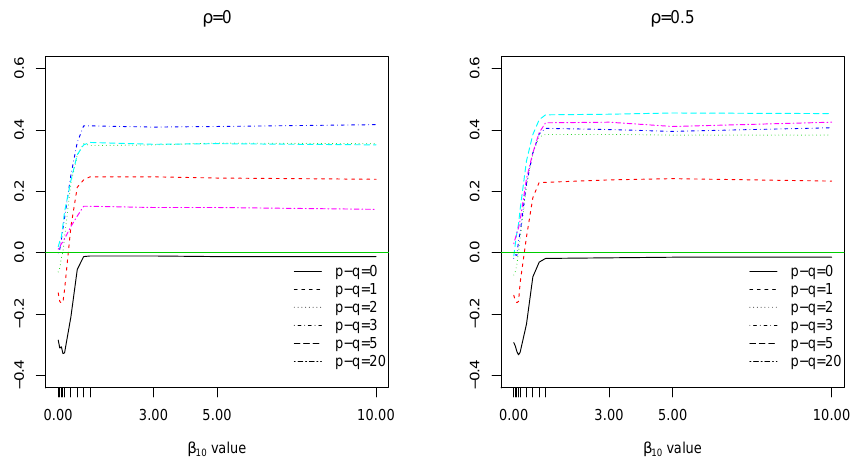
Figure 5. Difference in proportions of selecting true model: P c ( λ 1 se ) − P c ( λ min ) (positive means 1se is